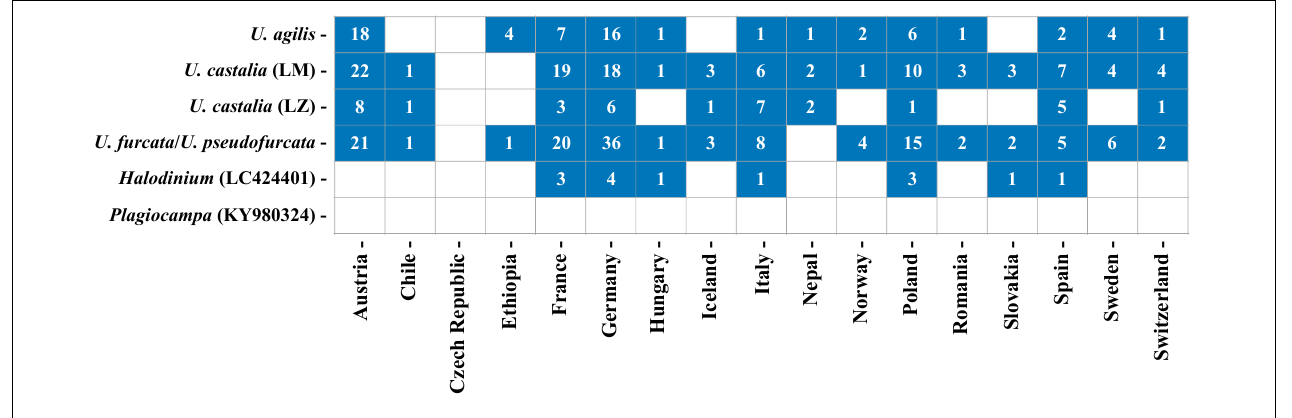
FIGURE 10 | Distribution of the investigated Urotricha strains. Blue squares indicate the occurrence of V4- or V9-markers in a country and the numbers give the number of lakes in which the V4- or V9-markers were found per country. Detailed information about the investigated freshwater lakes can be retrieved from Supplementary Table 2 . Since U. furcata and U. pseudofurcata show a 100% sequence similarity in their V9-region, only results for U. furcata are shown.